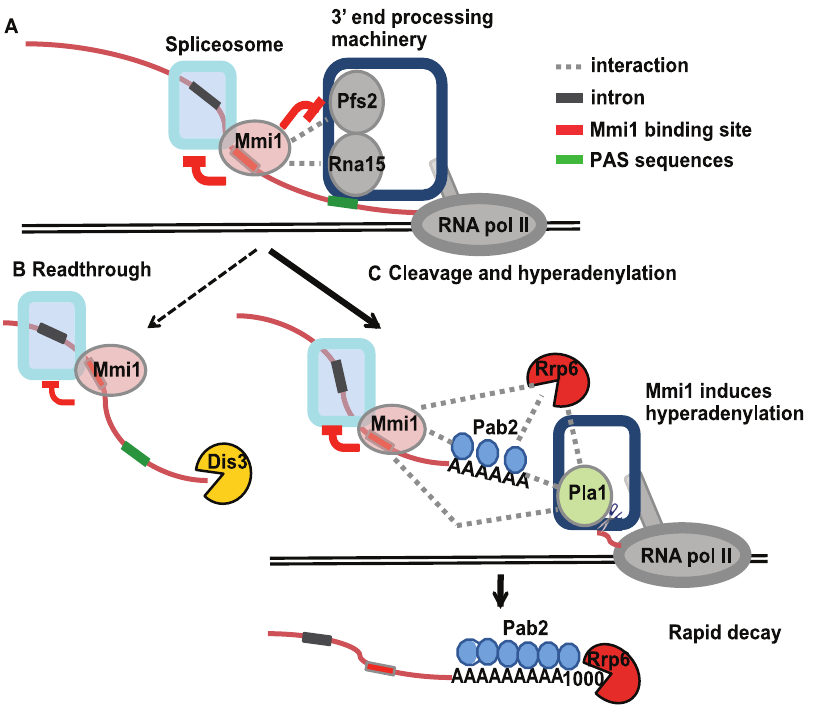
Figure 7. Model of Mmi1 function. (A) Mmi1 binds the nascent transcript and inhibits splicing. (B) Mmi1 also inhibits cleavage on , 5% of transcripts. These read-through transcripts are removed by Dis3. (C) Mmi1 promotes hyperadenylation. This hyperadenylation also depends on the polyA polymerase Pla1 [6] and probably Pab2. Hyperadenylated transcripts are rapidly degraded by Rrp6. Protein-protein interactions are shown by dotted lines based on the following evidence: Mmi1-Pfs2: genetic interactions (data not shown); Mmi1-Rna15: yeast two-hybrid and co-IP [6]; Mmi1- Pab2 and Mmi1-Pla1: yeast two-hybrid and co-IP [6]; Mmi1-Rrp6: unpublished observation [3]; Rrp6-Pab2: co-IP [9]; Rrp6-Pla1: synthetic rescue in budding yeast [58] and Pab2-Pla1: biochemical interaction in mammalian cells